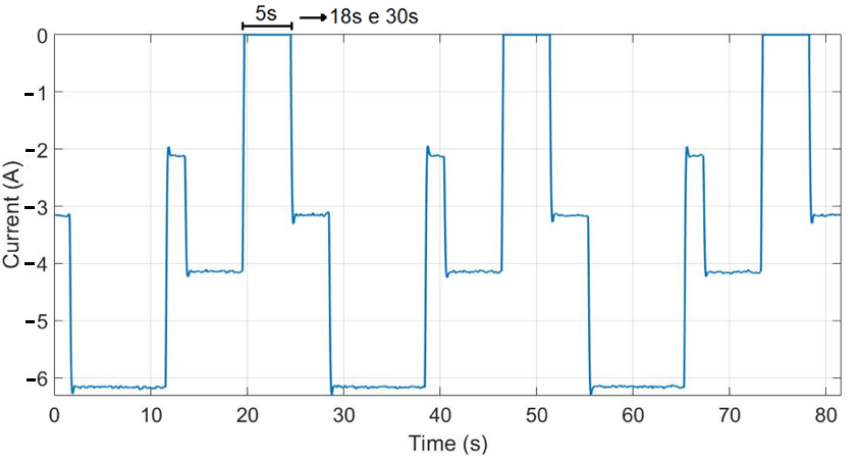
Figure 10. Long current pulses, with a resting time of 5 s during the bursts.